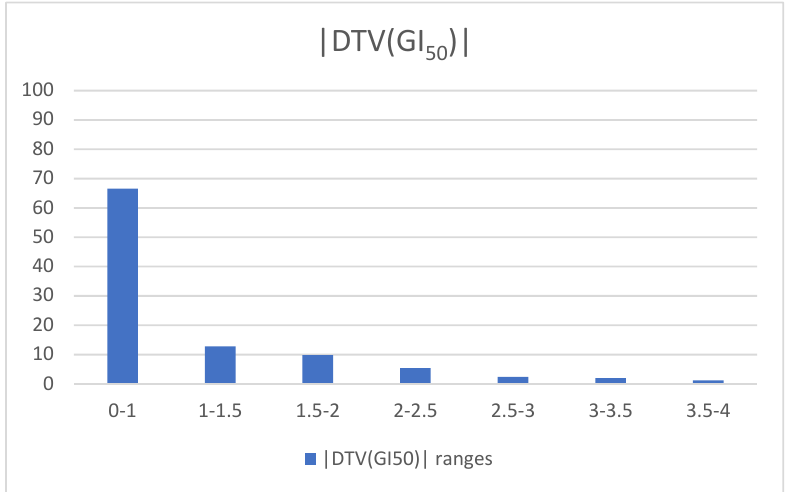
Figure 5. |DTV(GI 50 )| vs. frequencies of the data for the external test validation.